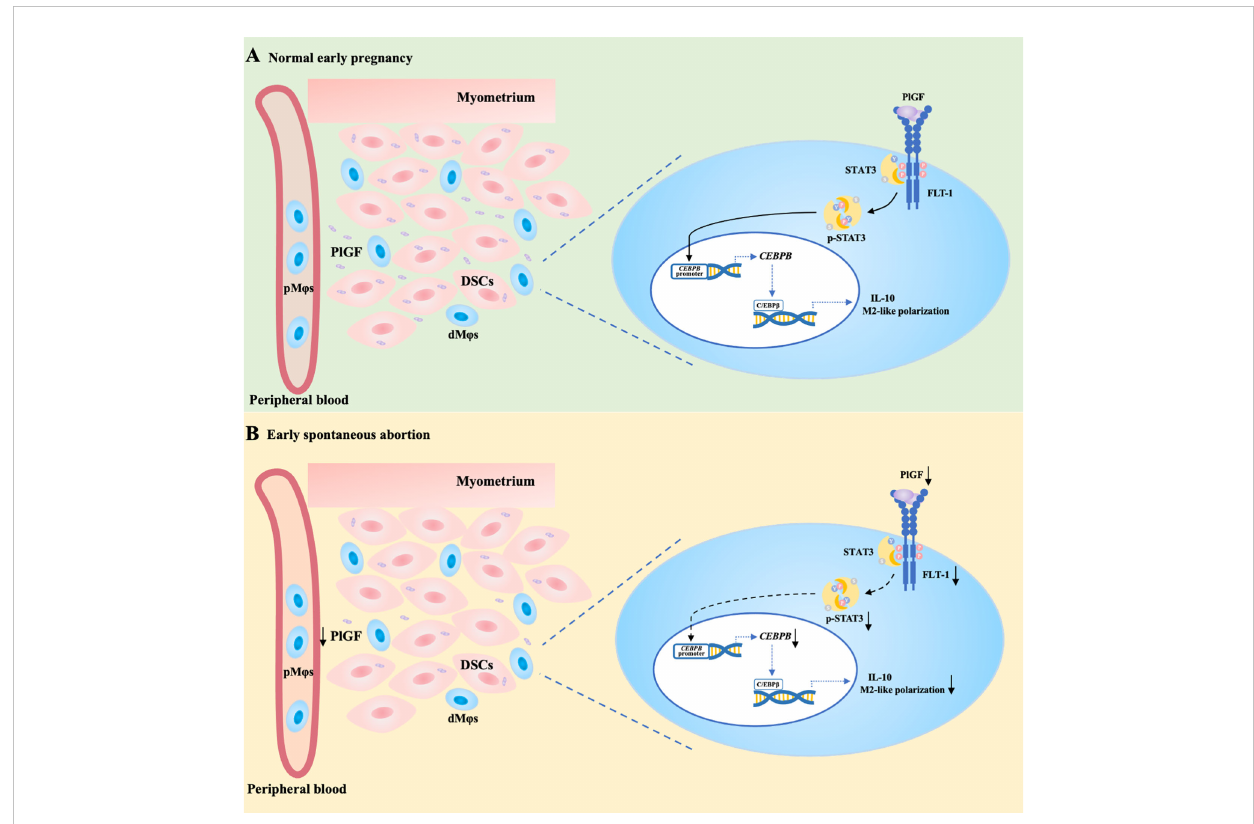
FIGURE 6 PlGF/FLT-1 de fi ciency leads to reduced STAT3-C/EBP b signaling and aberrant polarization in decidual macrophages during early spontaneous abortion. (A) In normal pregnancy, PlGF secreted by decidual stromal cells (DSCs) promotes the M2-like polarization and IL-10 production in decidual macrophages (dM j s) by binding to its receptor FLT-1 expressing on dM j s and thereby up-regulating the level of p-STAT3, which induces CEBPB transcription. (B) In early spontaneous abortion, the de fi ciency of PlGF/FLT-1 leads to the decreased tyrosine phosphorylation and transcriptional activity of STAT3, then the reduced C/EBP b expression, and eventually the aberrant polarization of dM j s. p-STAT3, phosphorylated